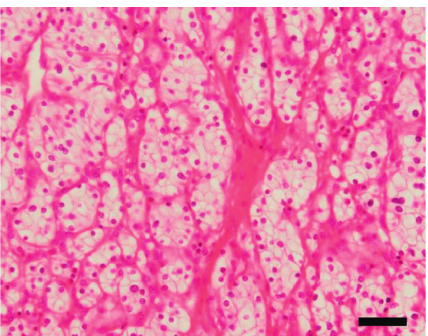
Figure 2: Histopathological findings of the renal cell carcinoma. Hematoxylin and eosin staining. The tumor cells had small round nuclei and clear cytoplasm with cell atypia. The tumor cells showed trabecular pattern with abundant vessels in the tumor stroma. These findings were consistent with grade 2 clear-cell renal cell carcinoma. Bar, 50 µ